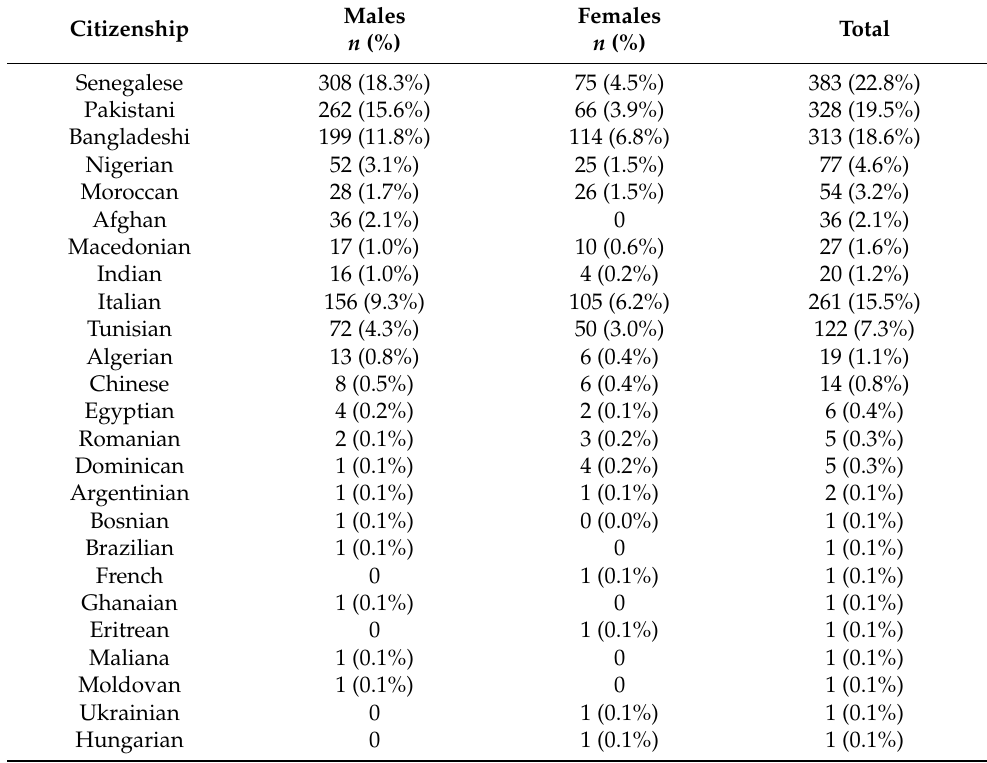
Table 1. Frequency and percentages of residents in Hotel